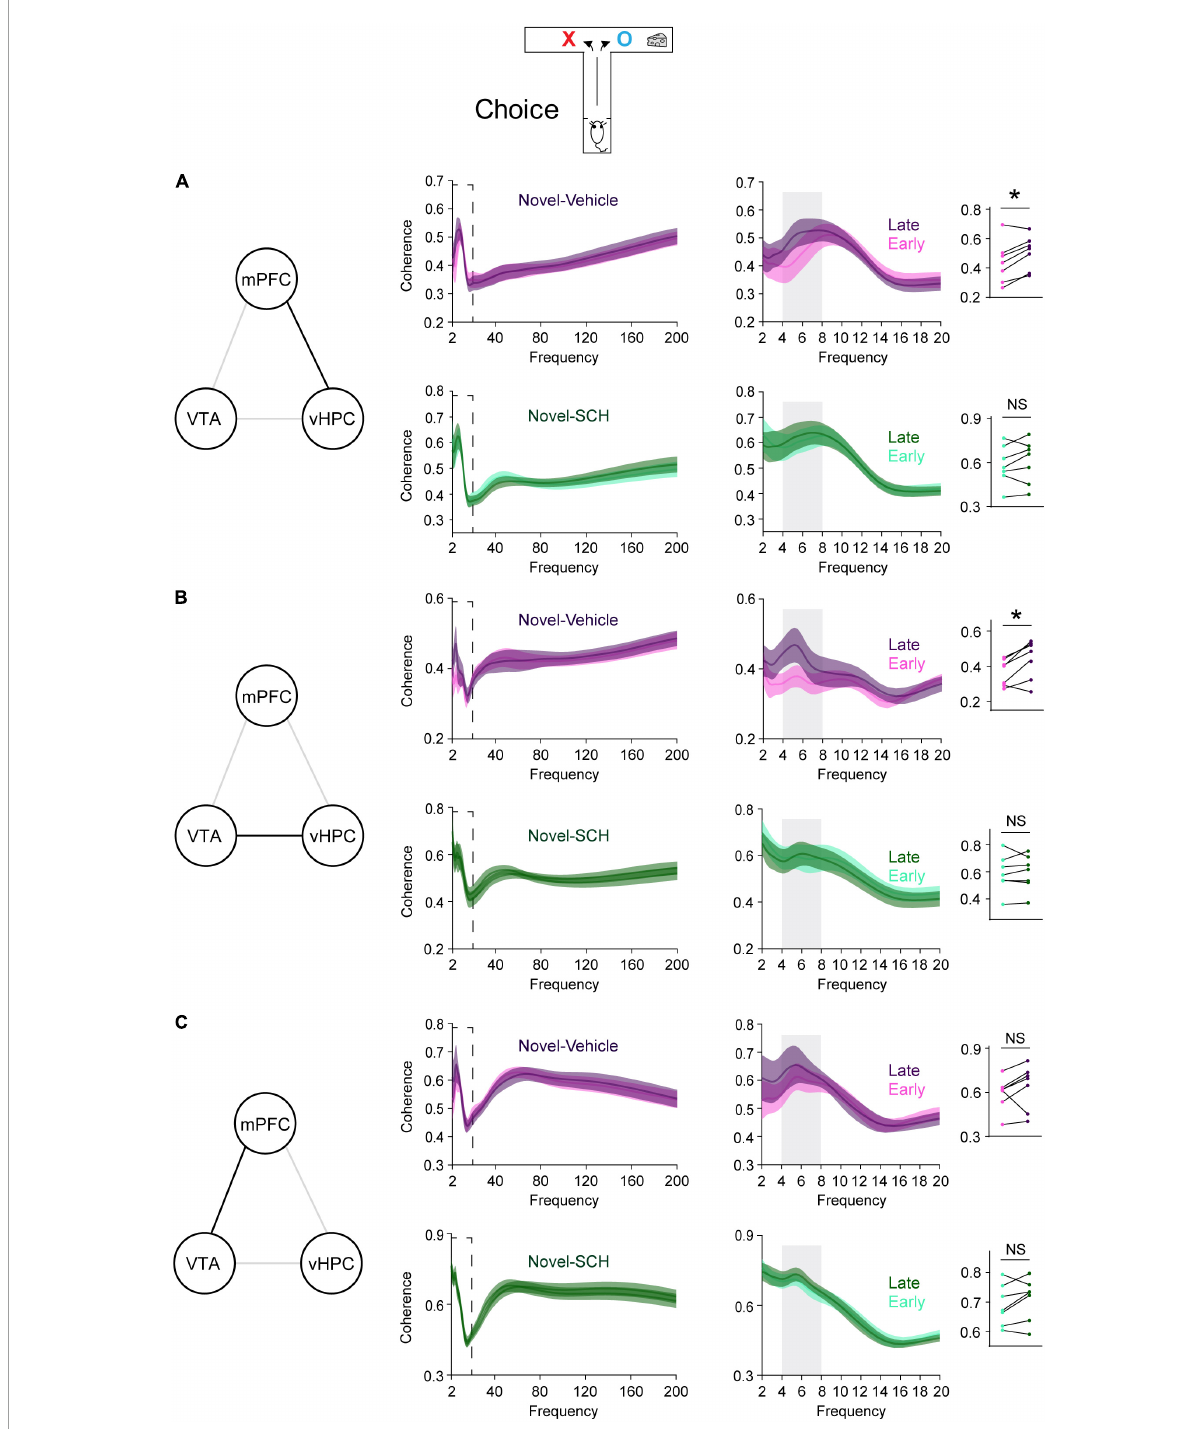
FIGURE4 Blocking D1Rs in the vHPC prevents novelty-induced selective increases in theta coherence in the VTA-vHPC-mPFC circuit when mice flexibly choose a goal side. Coherence in the dashed box on the left is shown on the right. Dot plots show the average theta coherence of each mouse. (A) Mice treated with vehicle, but not SCH, displayed increased vHPC-mPFC theta coherence in late training compared with that of early training (vehicle, P = 0.03; SCH, P = 0.4). (B) The vehicle, but not the SCH, group showed increased VTA-vHPC theta coherence in late training compared with that of early training (vehicle, P = 0.03; SCH, P = 0.8). (C) Both vehicle and SCH groups exhibited similar mPFC-VTA theta coherence between the early and late choice phase of flexible choice training (vehicle, P = 0.3; SCH, P = 0.2). Vehicle ( n = 7), SCH ( n = 7). Wilcoxon signed-rank test. NS. not significant, * P < 0.05. Data are represented as mean ±